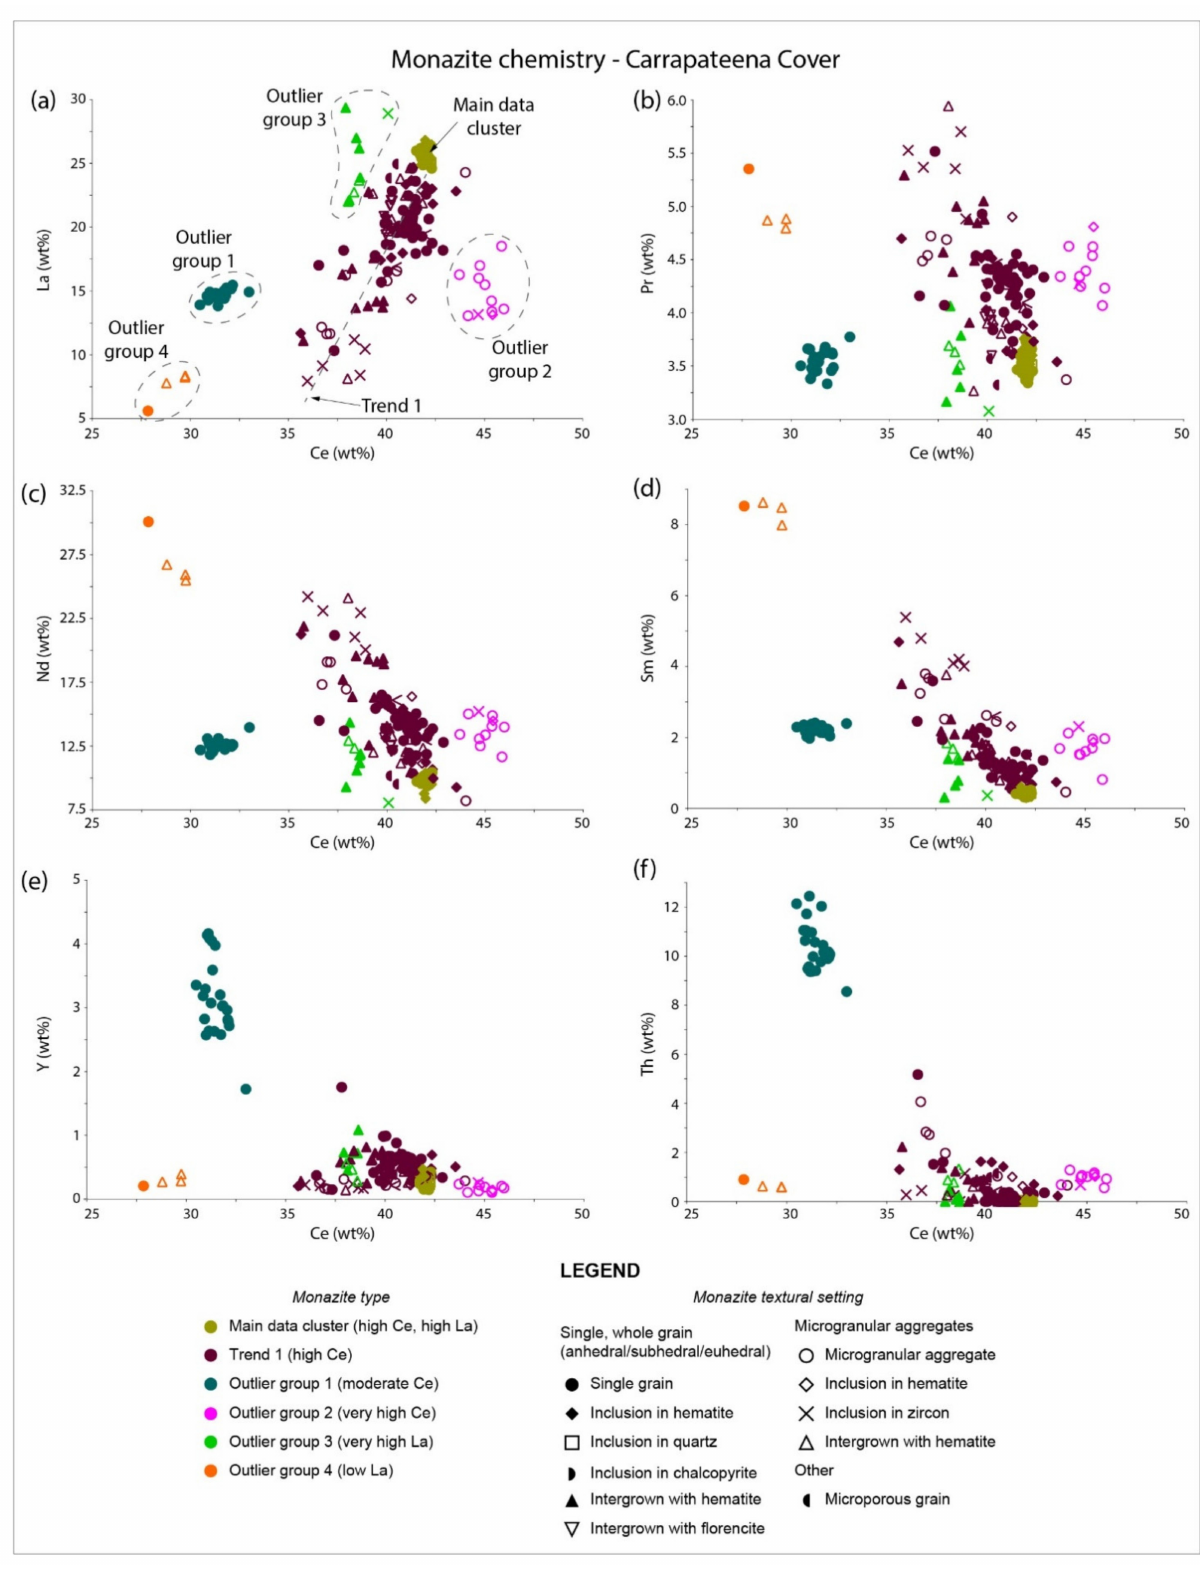
Figure 7. Geochemical plots for monazite from the cover sequence overlying the Carrapateena deposit. ( a ) Ce vs. La; ( b ) Ce vs. Pr; ( c ) Ce vs. Nd; ( d ) Ce vs. Sm; ( e ) Ce vs. Y; and ( f ) Ce vs.